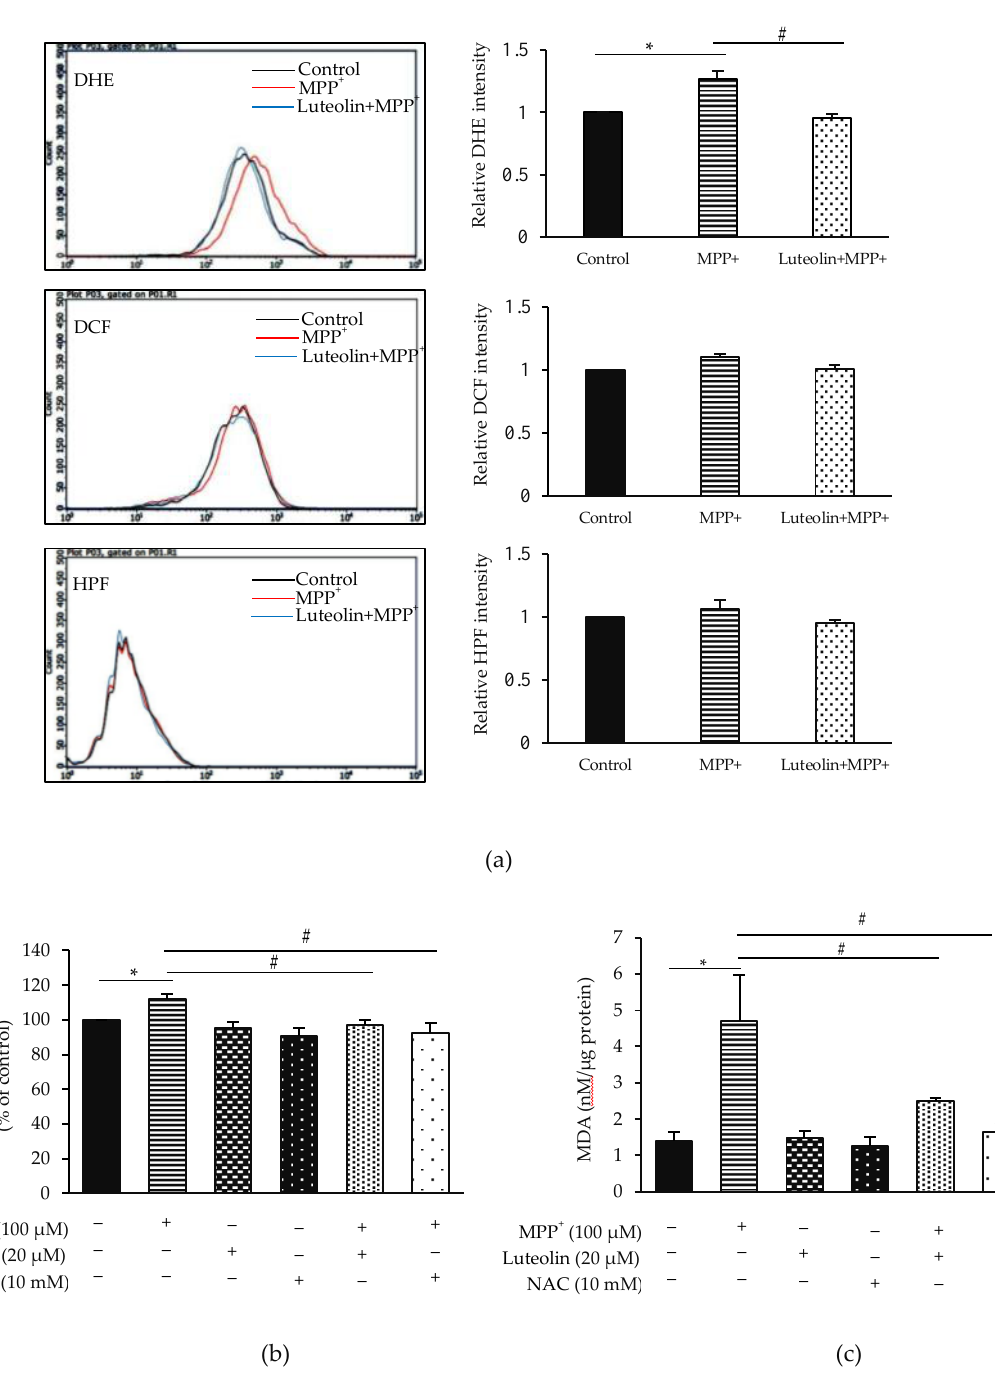
Figure 4. Luteolin protected MPP + -induced intracellular reactive oxygen species (ROS) and malondialdehyde (MDA) generation in SH-SY5Y cells. ( a ) The cells treated with 100 µ M MPP + for 24 h in the presence or absence of 20 µ M luteolin were incubated with specific ROS fluorescent probes, including DHE, DCF or HPF for 3 h. Fluorescence intensity of dihydroethidium (DHE), 2 (cid:48) ,7 (cid:48) -dichlorofluorescein (DCF) or hydroxyphenyl fluorescein (HPF) was analyzed by flow cytometry. Cells were pre-incubated with 20 µ M luteolin and 10 mM NAC for 1 h, followed by 100 µ M MPP + . Levels of ( b ) O 2 − and ( c ) MDA were measured by xanthine/xanthine oxidase systems and thiobarbituric acid reactive substances (TBARS) assay, respectively. Results presented as the mean ± SD for triplicated independent experiments. Differences are statistically significant at * p < 0.05 versus the control group and # p < 0.05 versus the MPP + group. DHE: dihydroethidium, DCF: 2 (cid:48) ,7 (cid:48) -dichlorofluorescein, HPF: hydroxyphenyl fluorescein and NAC: N-acetyl